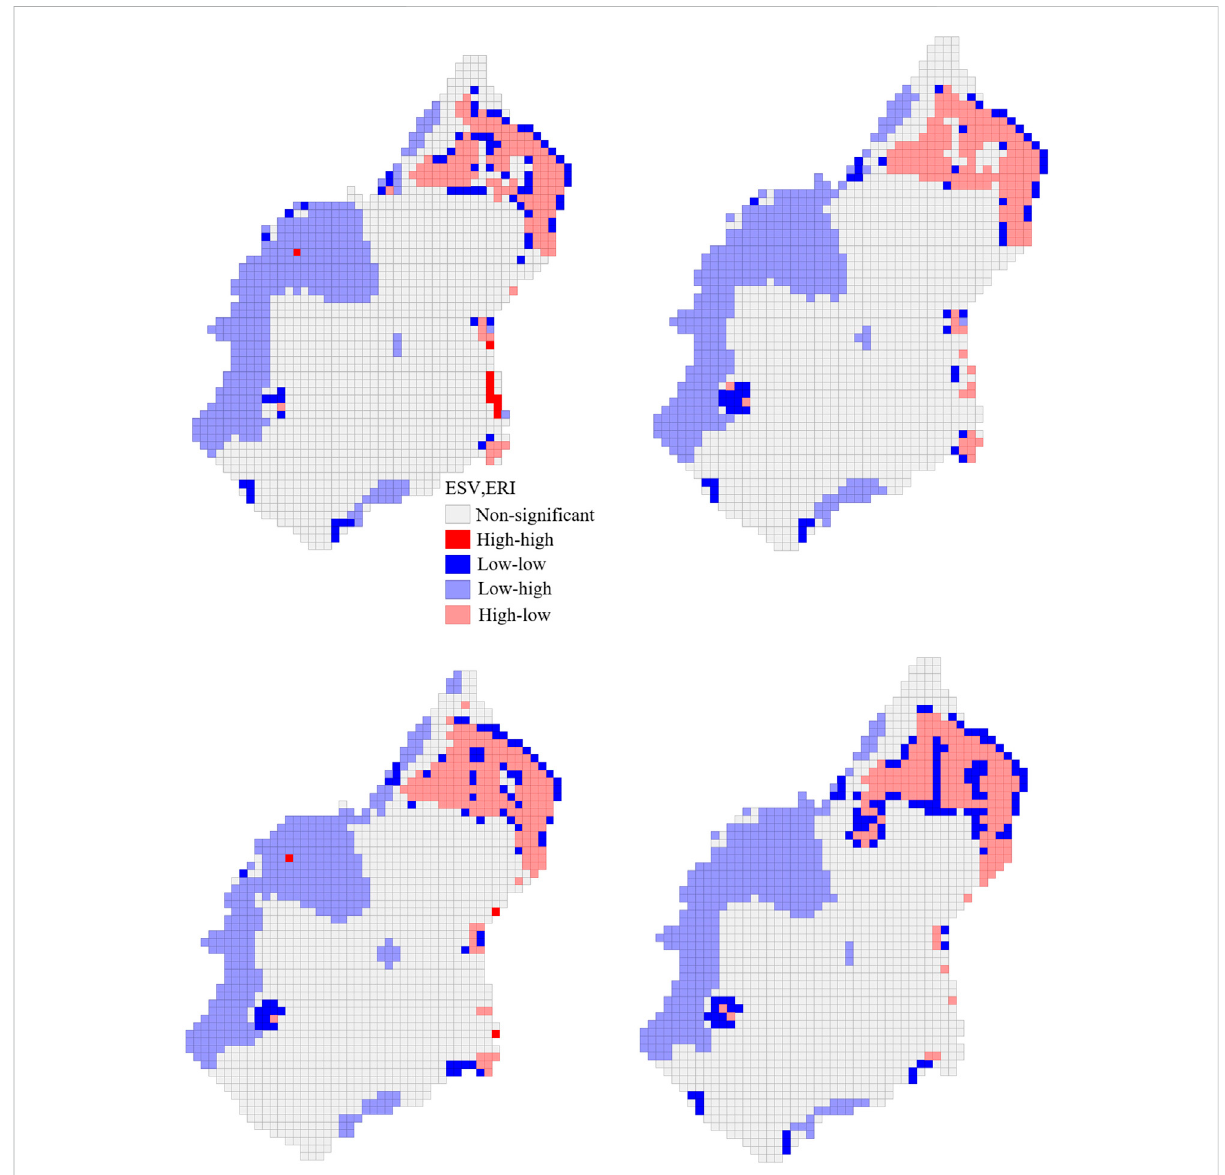
FIGURE 5 Spatial correlation distributions of ESV and ERI in the Ulan Buh Desert in 1990 –